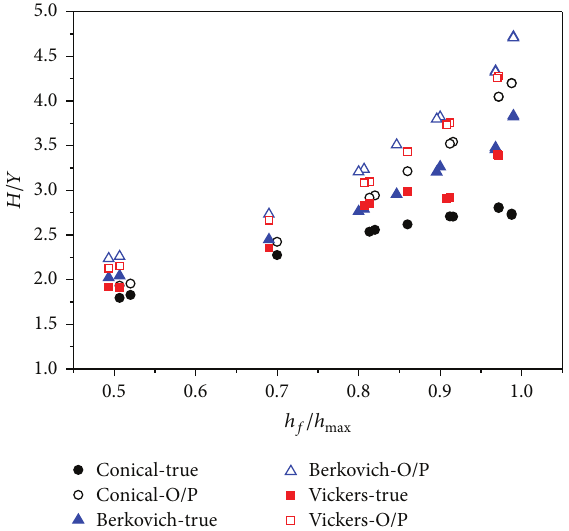
Figure 10: Influence of ℎ 𝑓 /ℎ max on the calculated elastic modulus. The modulus is normalized by the input 𝐸 of the numerical model. The solid icons stand for the elastic modulus derived from true projected contact areas (6), while the hollow icons represent the modulus derived by Oliver and Pharr model [1]. The solid and dashed lines are linear fitting of solid icons and hollow icons, respectively.